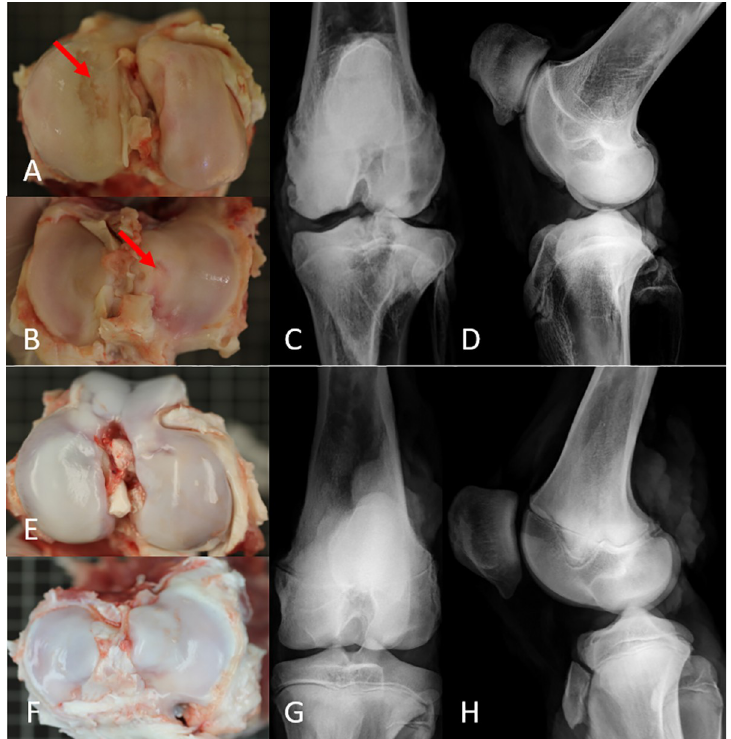
Fig 2. View of the exposed stifle joints of pigs and corresponding X-rays. Femoral condyles (A) and the tibial plateau (B) of a stifle joint originating from an old pig show severe macroscopically visible OA alterations (red arrows); deep articular cartilage loss led to the exposure of the subchondral bone. (C) and (D) show the X- rays of the joint in the anterior–posterior aspect (C) and in the side view (D). Images (E) and (F) show the stifle joint originating from a young pig. Only slight alterations on the medial tibia plateau (F) can be detected. (G) and (H) show the X-rays of the same joint. The growth plates indicate the young age of the animal.